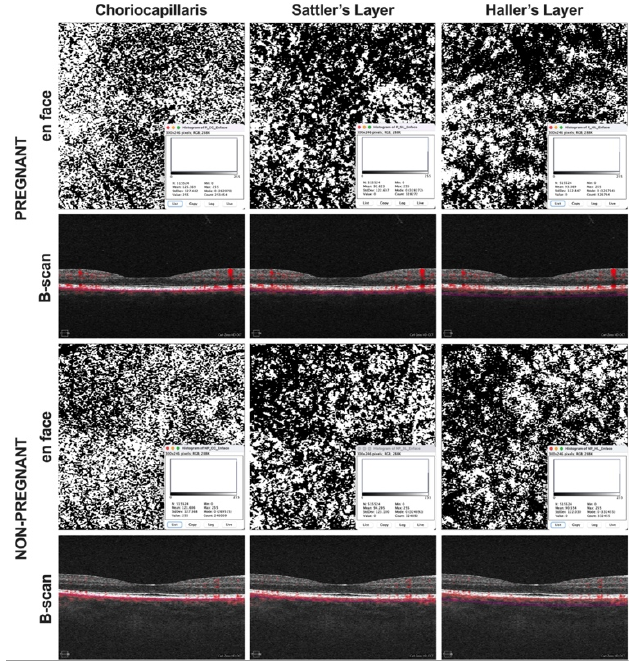
Figure 2. Binarization of angiograms. Images were exported into ImageJ and binarized using the Otsu method. The percentage of white (CC) or black pixels (SL and HL) was considered an indirect measure of the choroidal vascular flow area.